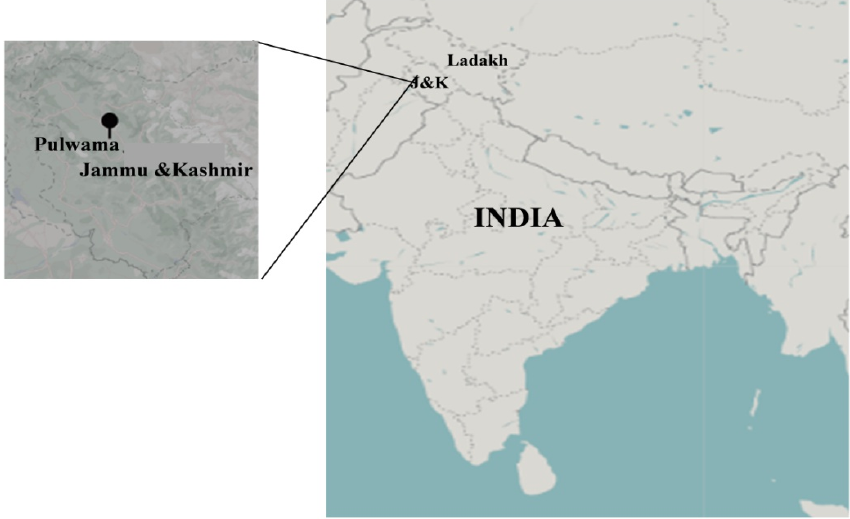
Figure 1. Map representing sample collection site. Agrobacterium tumefaciens strain GV3101 with egfp gene containing plasmid [29] was used for the transformation of Fox R1. The bacterial culture was grown in Luria Bertani broth supplemented with 100 µg/mL kanamycin and 30 µg/mL rifampicin, at 28 °C and 150 rpm for 24 h [30].